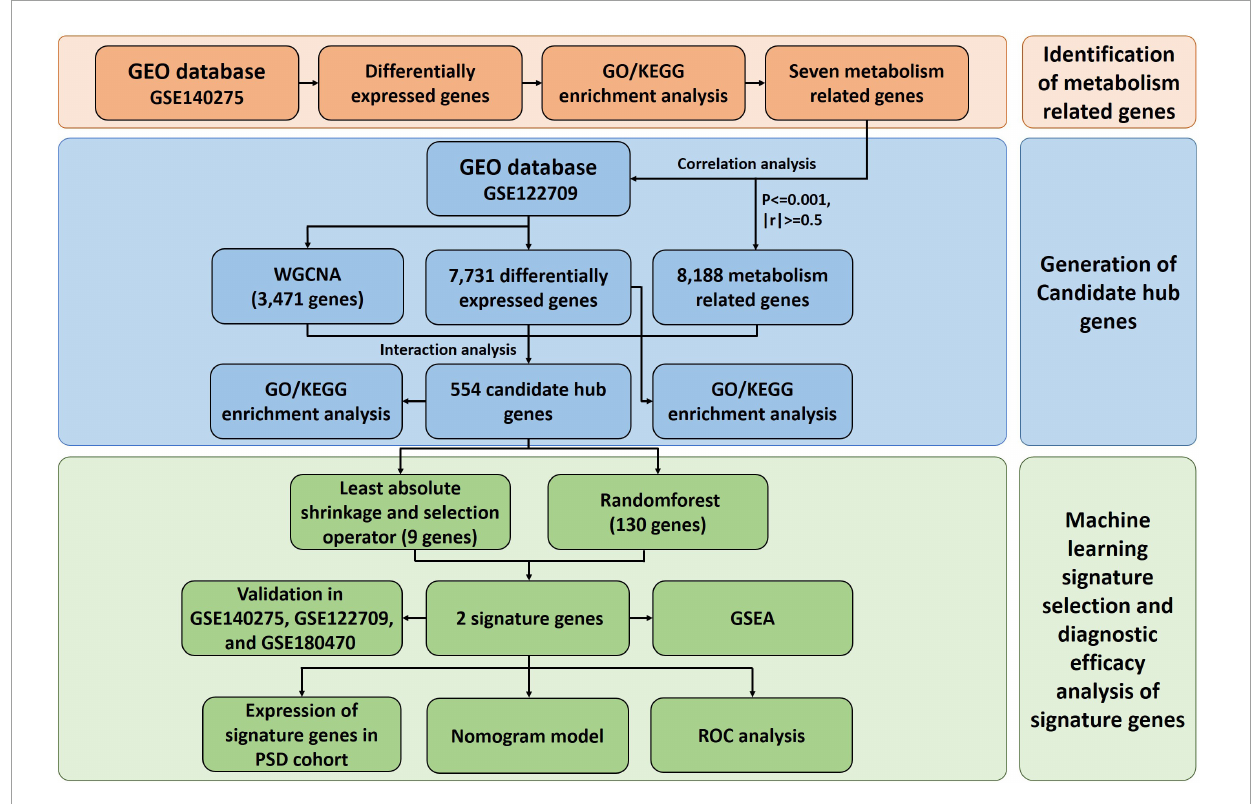
FIGURE1 Flow chart. GEO, Gene Expression Omnibus; WGCNA, weighted gene co-expression network analysis; PSD, post-stroke depression; ROC, receiver operating characteristic; GO, gene ontology; KEGG, Kyoto Encyclopedia of Genes and Genomes; GSEA, gene set enrichment analysis.